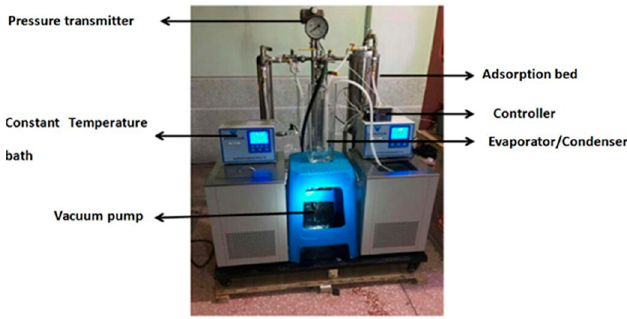
Figure 16. Adsorption refrigeration system performance test device.